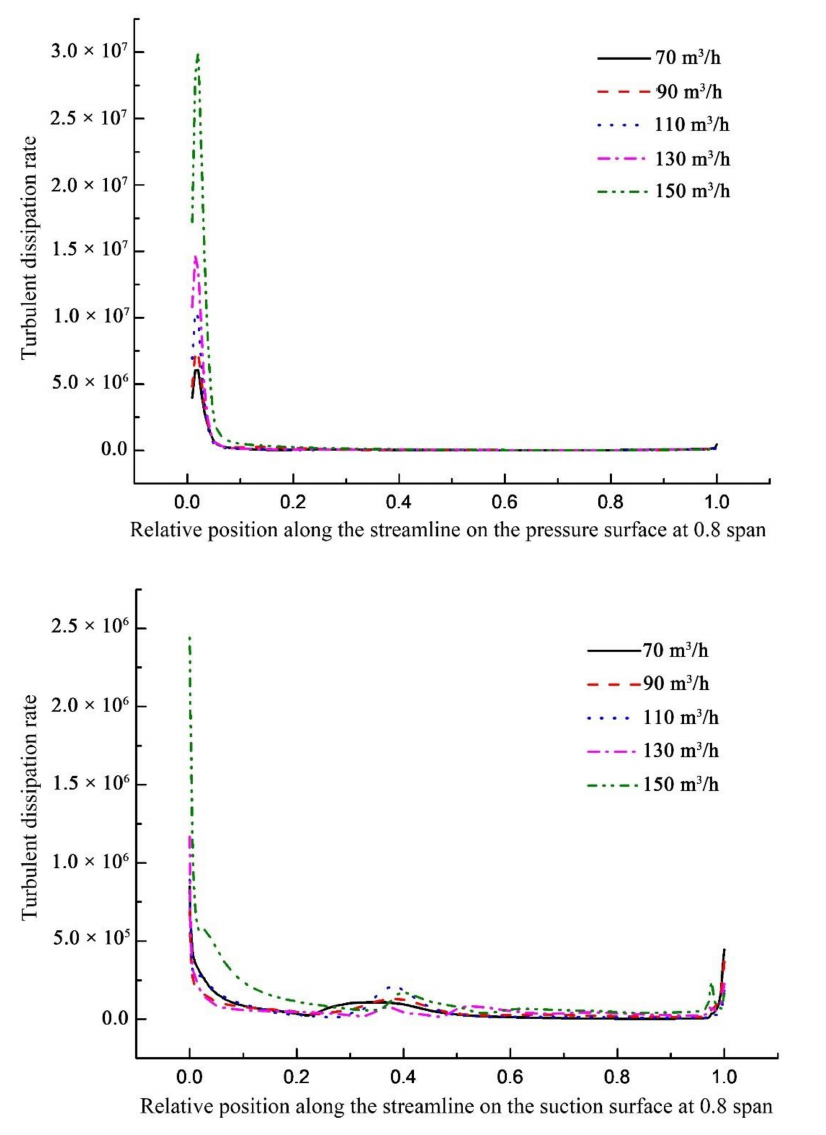
Figure 14. The turbulence dissipation rate distribution pattern of the pressure surface and the suction surface of the first-stage impeller blade at the shroud under different flow